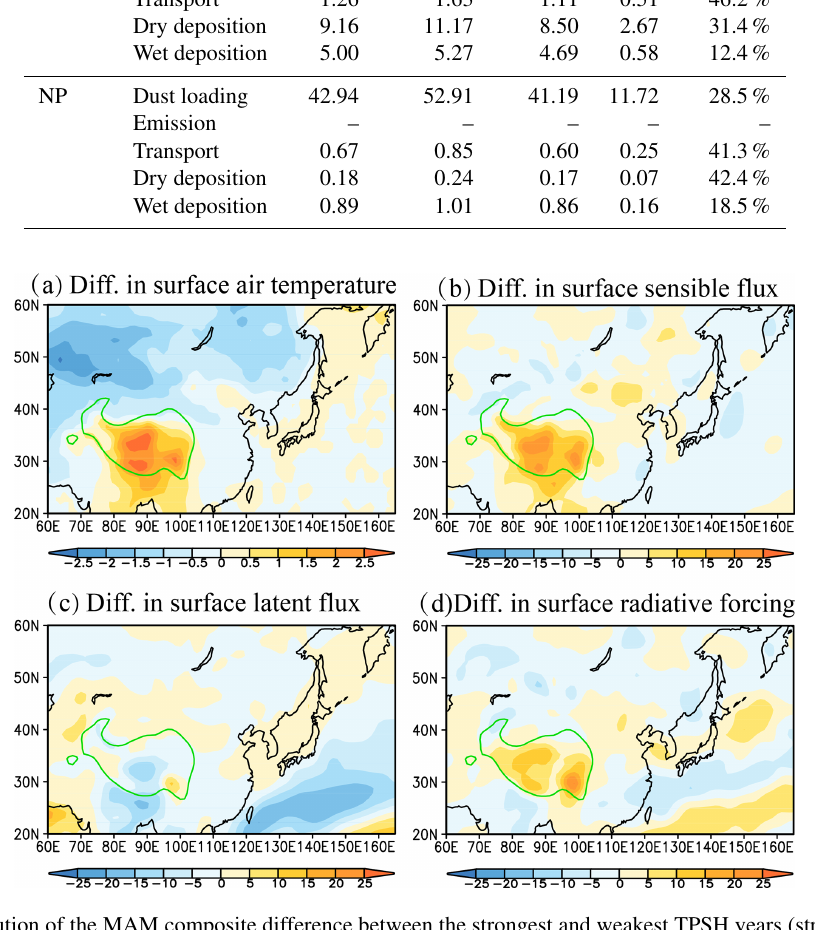
Figure 7. Spatial distribution of the MAM composite difference between the strongest and weakest TPSH years (strongest–weakest) for the model in (a) the surface air temperature ( ◦ C), (b) the surface sensible heat (Wm − 2 ), (c) the surface latent heat (Wm − 2 ), and (d) the surface radiative forcing (Wm − 2 ). The green-contour area indicates the plateau above